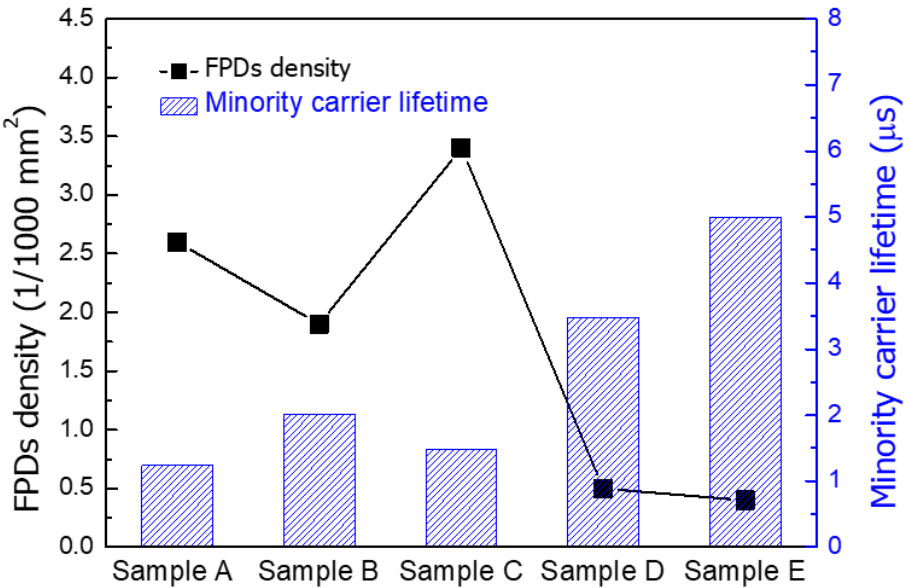
Figure 4. Relationship between average minority carrier lifetime and the number of FPDs for samples A, B, C, D, and E.